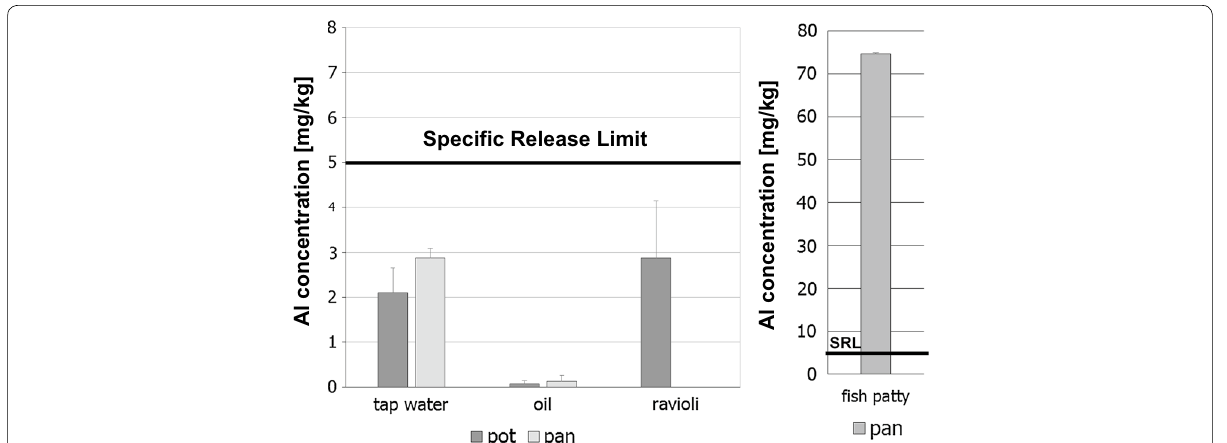
Fig. 7 Aluminum concentration in foodstuffs (water, oil, ravioli, and fish patties) after a contact period of 2 h at 105 °C in pots and pans made of aluminum. The heavy line at 5.00 mg/L denotes the SRL [2]